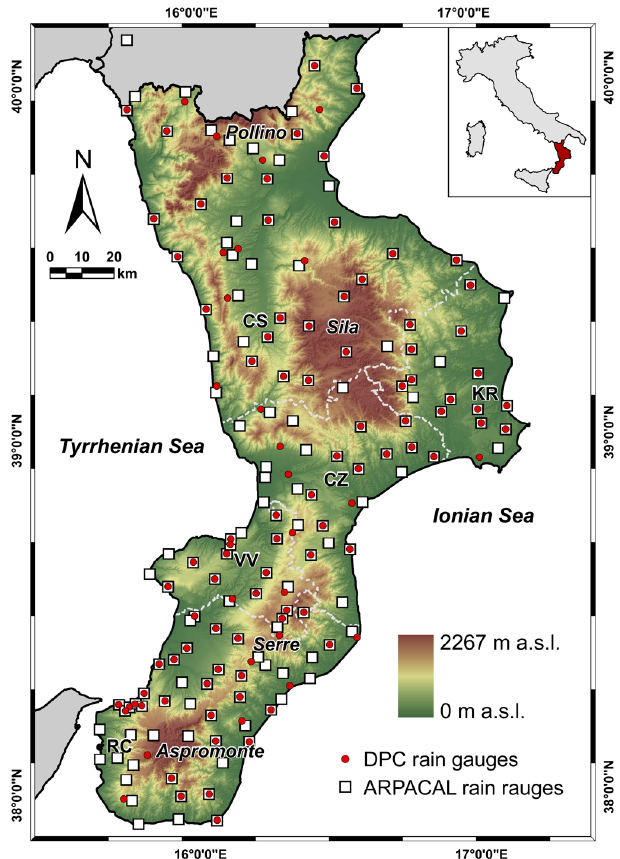
Fig. 1. Terrain elevation map for Calabria, southern Italy. Shades of colour show terrain elevations from sea level (dark green) to 2267m (brown). Red dots show location of rain gauges of the National De- partment of Civil Protection. White squares show location of rain gauges of the Regional Agency for Environmental Protection in Calabria. White dashed lines are province boundaries. Legend: CS, Cosenza; CZ, Catanzaro; KR, Crotone; RC, Reggio di Calabria; VV, Vibo